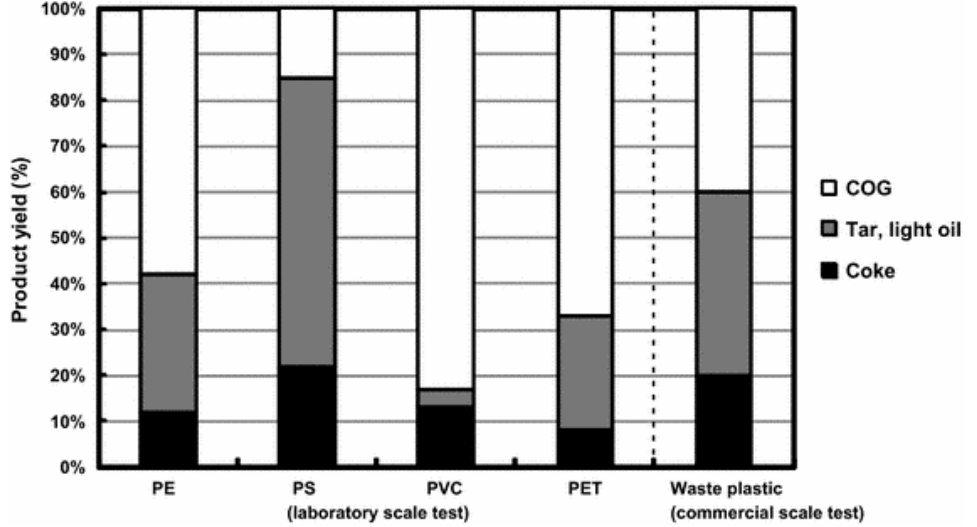
Figure 12. Effect of different plastic additions on the decomposition product yield (mass %) (Adapted from [50], with permission from © 2015 Springer Nature).